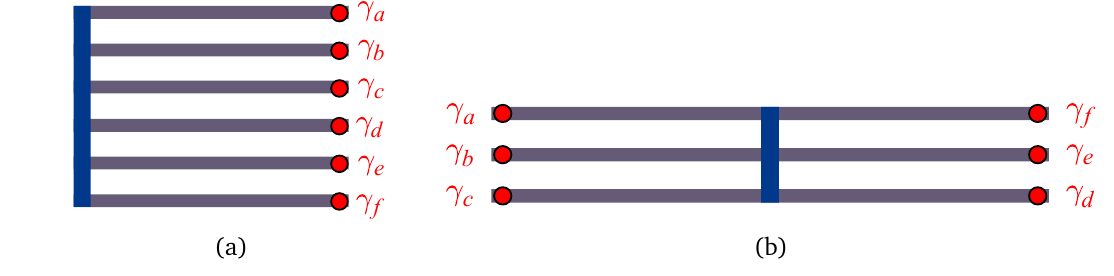
Figure 5: A labeling configuration 〈 a , b , c , d , e , f 〉 of MZMs shown for (a) one-sided hexons, which follow the labeling order from top to bottom, and (b) two-sided hexons, which follow the labeling order counterclockwise from top-left to top-